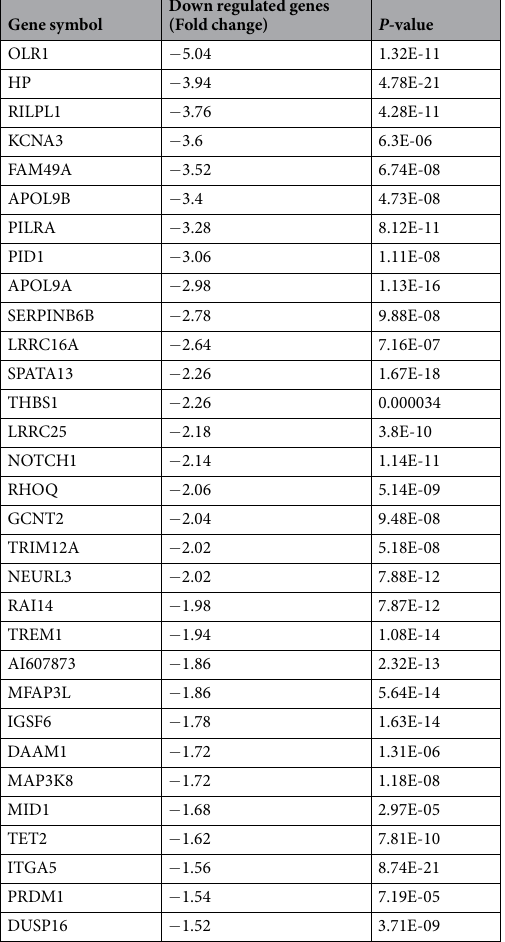
Table 2. GSK-J4 down-regulated unique genes in LPS treated BV-2 microglial